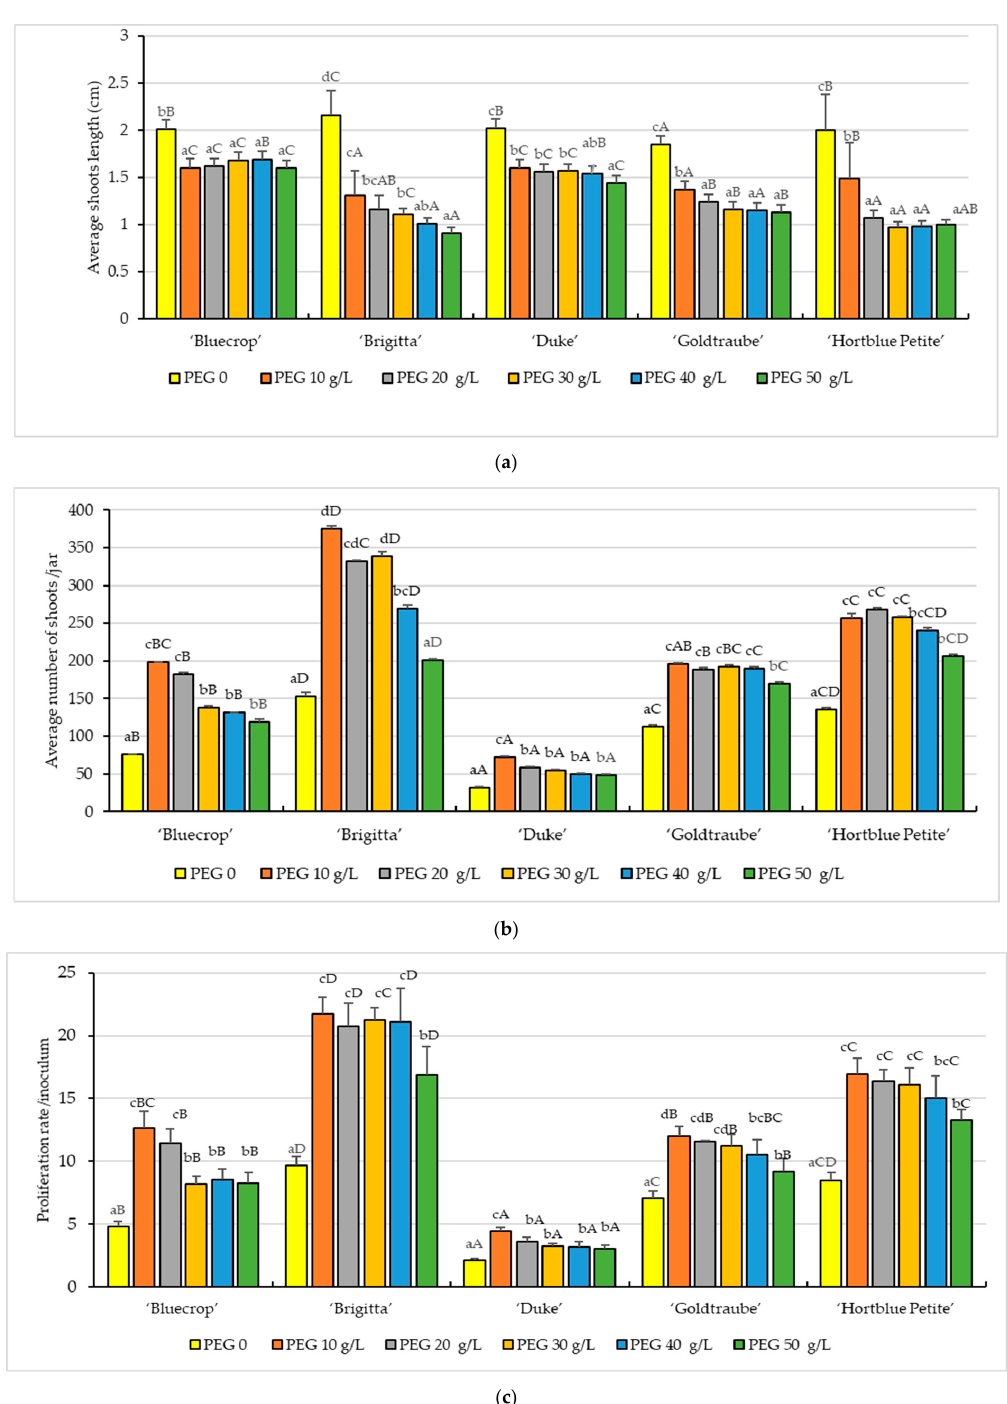
Figure 2. Effects of drought stress on ( a ) shoot length (cm), ( b ) average number of shoots/culture vessel, and ( c ) proliferation rate of five in vitro-grown highbush blueberry cultivars (Bluecrop, Brigitta Blue, Duke, Goldtraube and Hortblue Petite). For inducing the drought stress in culture media [Woody Plant Medium (WPM) + 100 mg/L Sequestren 138 + 1 mg/L zeatin (Z) + 4 g/L Plant agar, pH = 5] were added different concentrations polyethylene glycol (PEG 6000) (0 g/L, 10 g/L, 20 g/L, 30 g/L, 40 g/L, 50 g/L). Error bars indicate mean ± SE, and different lowercase letters within each cultivar indicate significant differences among the treatments and different capital letters indicate significant differences among the cultivars undergoing the same treatment according to Tukey’s HSD test ( p <